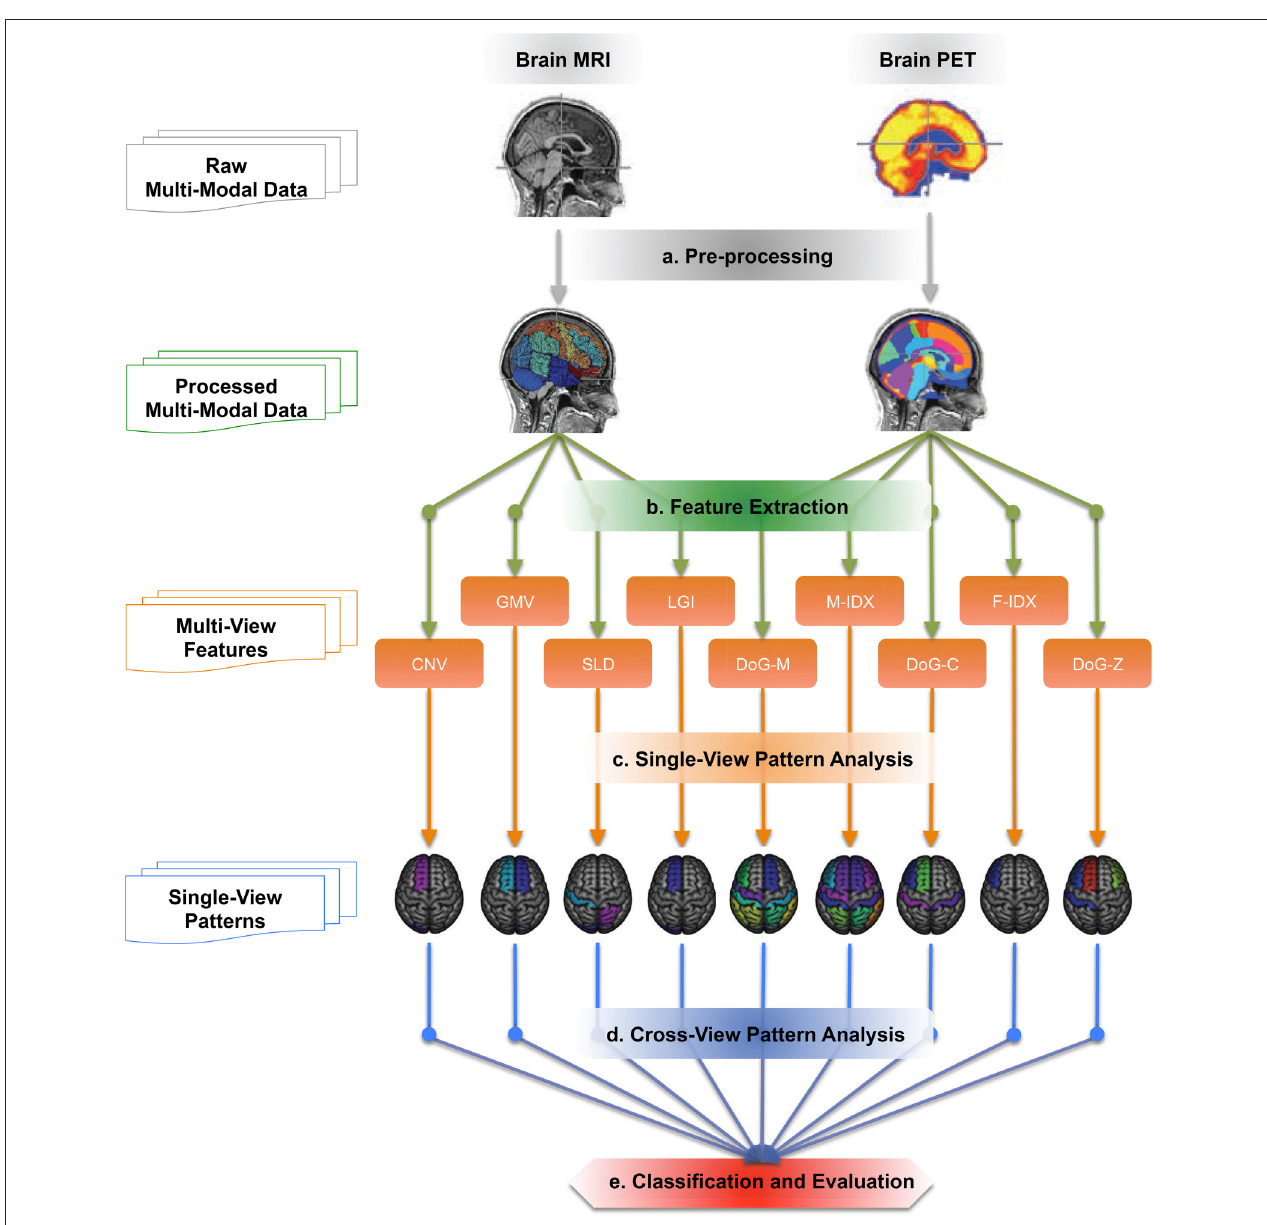
FIGURE 1 | The work-flow of the cross-view pattern analysis. It is a five-step pipeline, which takes brain T1-MRI and FDG-PET images as inputs and generates the classification results as the outputs.